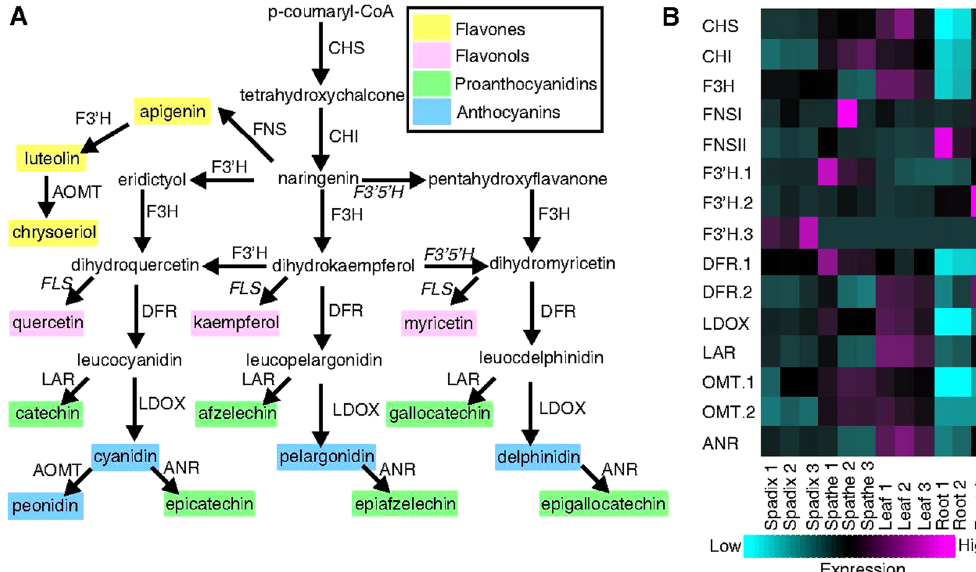
Figure 6. Flavonoid biosynthesis pathway and A . amnicola flavonoid unigene expression across organ type. ( A ) An overview of the flavonoid biosynthesis pathway enzymes and metabolites. Homologs for F3 ′ 5 ′ H and FLS (in italics) could not be confidently identified in the transcriptome assembly. Abbreviations are as follows: CHS (chalcone synthase), CHI (chalcone isomerase), F3H (naringenin 3-dioxygenase), FNS (flavone synthase), DFR (dihydroflavonol 4-reductase), LDOX (leucoanthocyanidin dioxygenase), F3 ′ H (flavonoid 3 ′ -monooxygenase), F3 ′ 5 ′ H (flavonoid 3 ′ ,5 ′ -hydroxylase), FLS (flavonol synthase), LAR (leucoanthocyanidin reductase), AOMT (anthocyanidin O-methyl transferase), and ANR (anthocyanidin reductase). ( B ) A heatmap of the expression profiles of flavonoid biosynthesis pathway genes identified in the Anthurium amnicola transcriptome. Magenta is high expression, cyan is low expression. Unigene IDs are shown in Supplementary Table